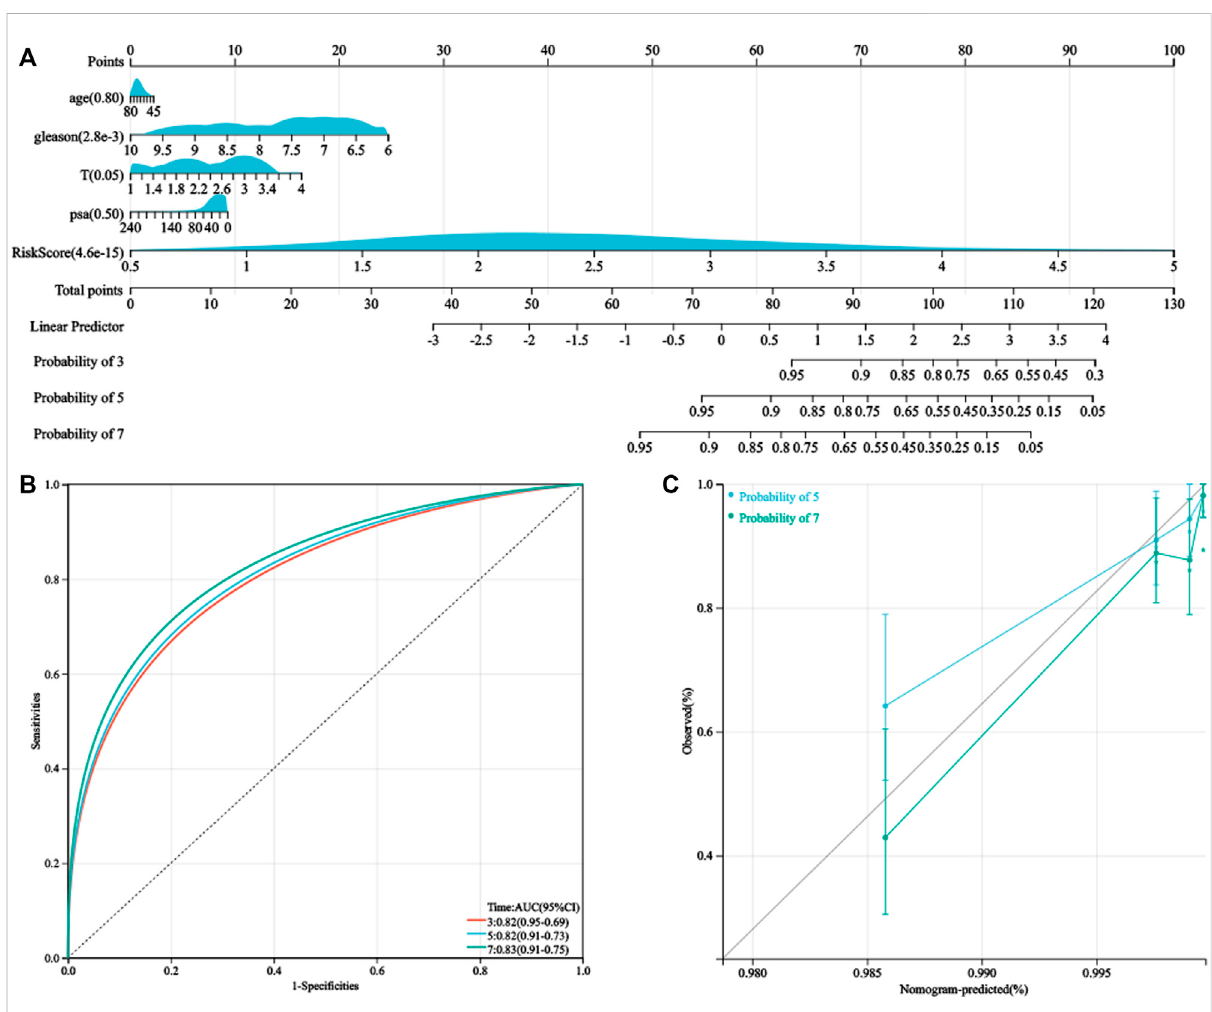
FIGURE 5 Nomogram was generated to improve risk strati fi cation and estimate survival probability. (A) Comprehensive nomogram for predicting probabilities of PC patients with 3-, 5-, and 7-year BCR-free survival in GSE116918 dataset. (B) ROC analyses of 3-, 5-, and 7-year BCR-free survival for this nomogram. (C) Calibration plots for predicting PC patients with 5- and 7-year BCR-free survival in